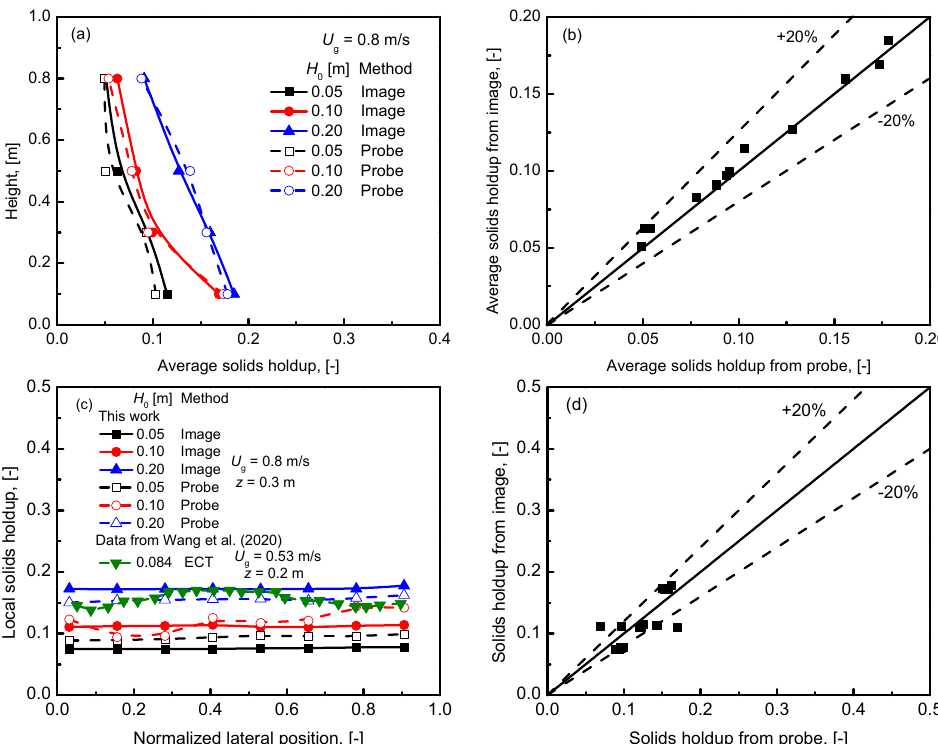
Figure 14. Solids holdup distribution based on image measurement along the gas-solids turbulent fluidized bed with Group A particles. ( a ) Comparison of axial distribution of solids holdup. ( b ) Com- parison of error between image and probe in axial distribution. ( c ) Comparison of lateral distribution of solids holdup. ( d ) Comparison of error between image and probe in lateral distribution.